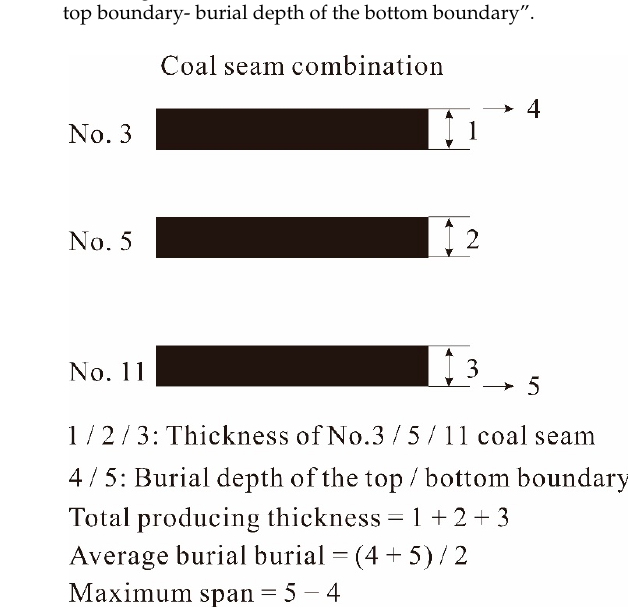
Figure 2. Illustration of the geometric parameters of the production coal seams. Table 1. Information on the CBM wells.